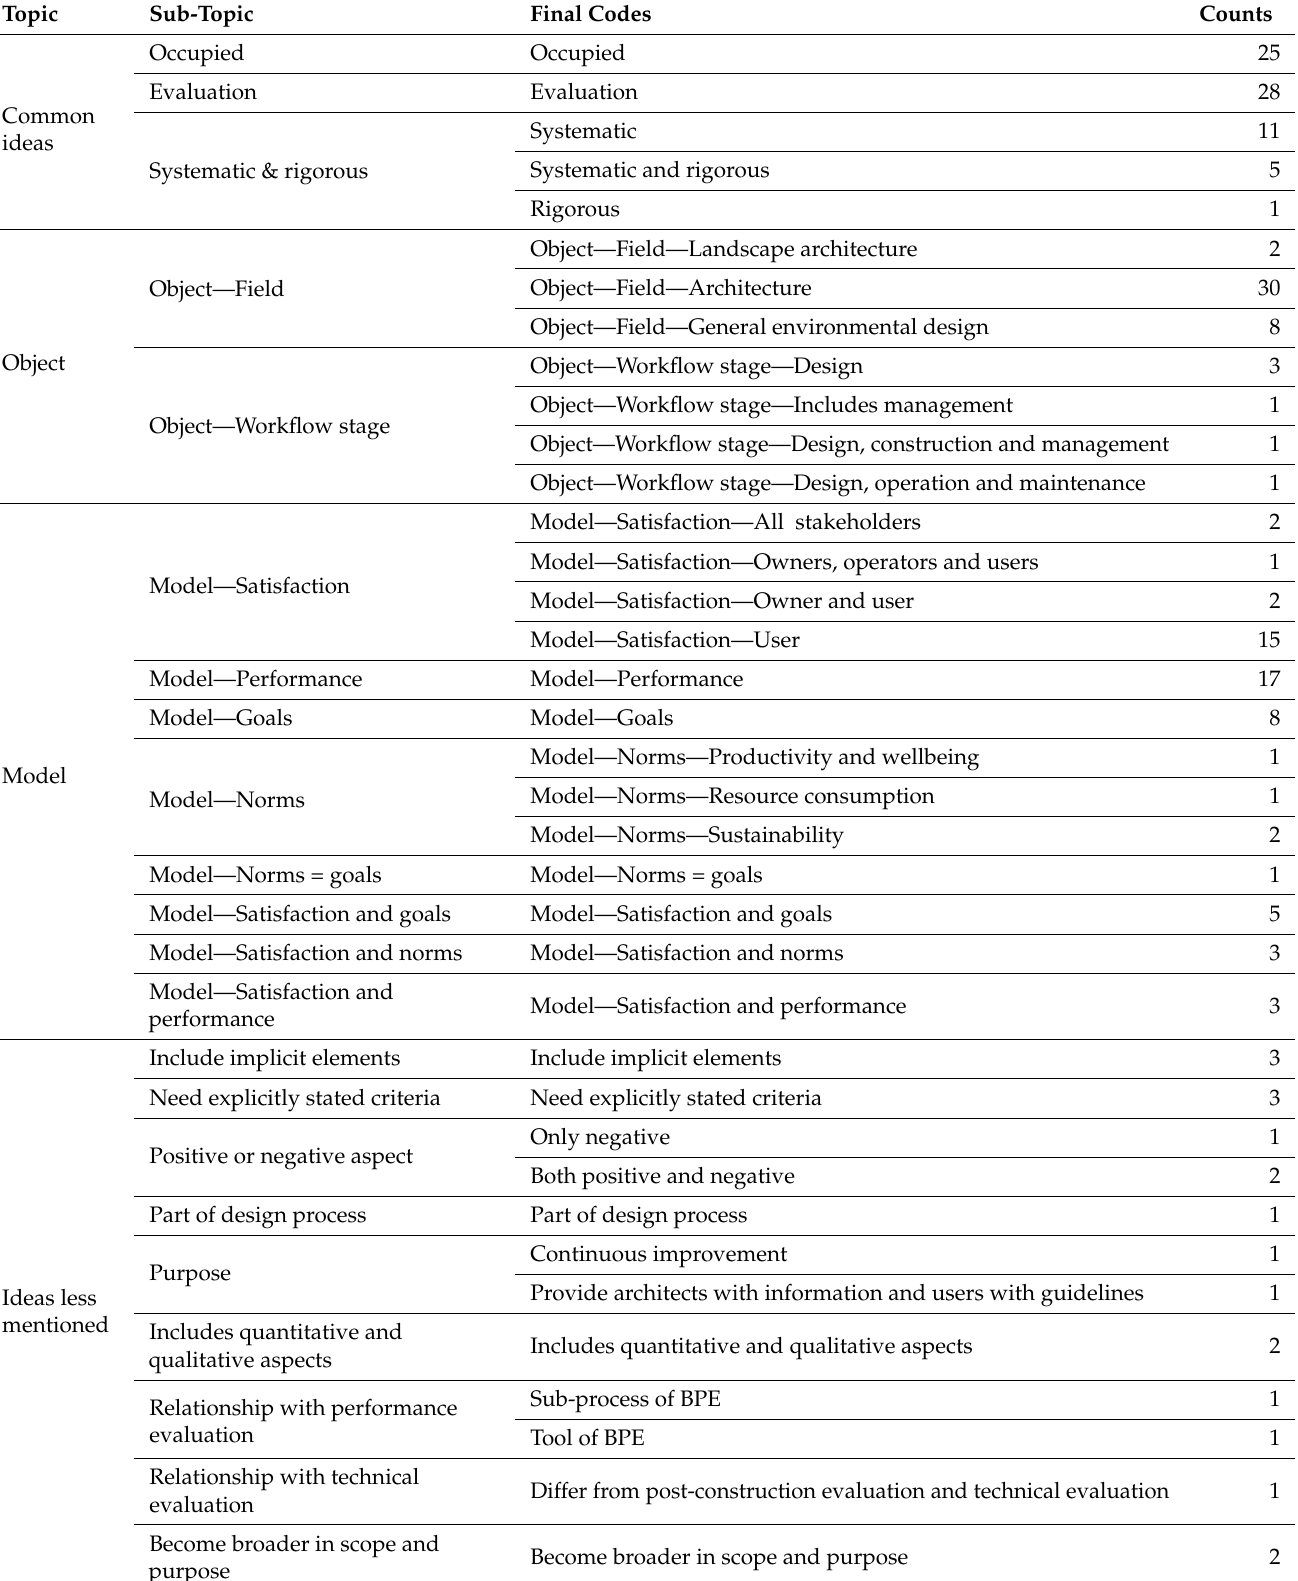
Table A5. Codes Count of the Final Definition